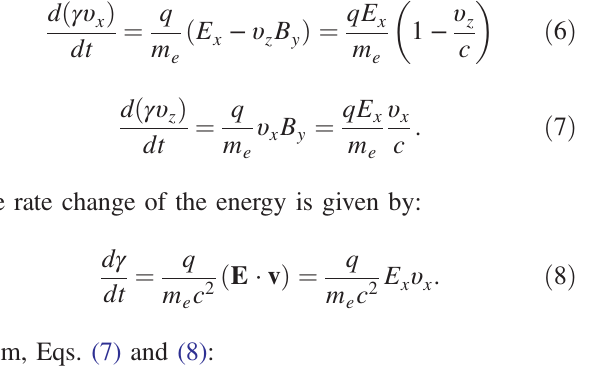
FIG. 3. Normalized angular distribution (scale factor ξ ) of the total energy radiated per unit solid angle ( E (a) I ¼ 5 × 10 19 W = cm 2 , (b) 10 20 W = cm 2 , (c), 5 × 10 20 W = cm 2 and (d) 10 21 W = cm 2 . The angle at which maximum energy is detected ( θ m ) vs laser intensity is presented as open circles in (e), and solid line represents the theoretical estimate as given by Eq.